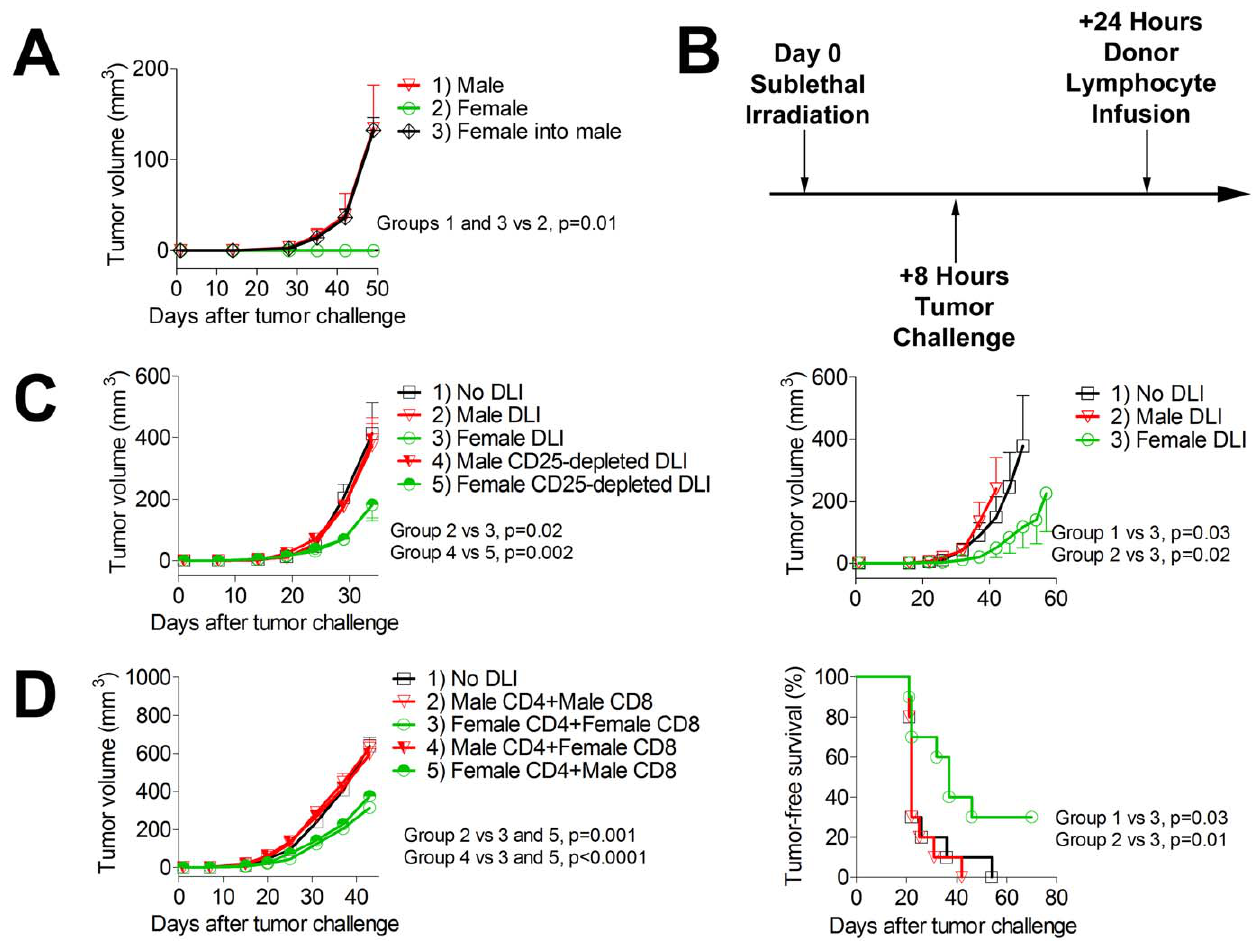
Figure 2. Adoptive transfer of female lymphocytes into male mice challenged with TRAMP-C2 controls tumor growth. A) Adult male mice were myeloablated via irradiation and transplanted with female T-cell depleted bone marrow followed by challenge with TRAMP-C2 tumors 10 weeks after transplantation. n=5 mice/group, results of a single experiment. B) Adult male mice were sublethally irradiated with 6 Gy and challenged intradermally with 1 6 10 6 TRAMP-C2. The following day, mice received a donor lymphocyte infusion (DLI) of 3 6 10 7 splenocytes i.v . n=10 mice/group, one of 3 experiments with similar results. C) Adoptively-transferred CD25 + regulatory T cells do not mediate increased tumor growth seen following male DLI. Mice were irradiated and tumor-challenged as in B, and received splenocytes that were CD25-depleted using magnetic beads where indicated. n=10 mice/group, results of a single experiment. D) Female CD4 T cells mediate delayed growth of TRAMP-C2 tumors. Mice were irradiated and tumor-challenged as in B, and then received 1.5 6 10 7 splenocytes that were in vivo CD4-depleted, mixed with 1.5 6 10 7 splenocytes that were CD8-depleted, of either male or female origin. n=10 mice/group, one of 2 experiments with similar results. doi:10.1371/journal.pone.0035222.g002 peptide epitopes derived from these antigens. Following re- stimulation with peptide-pulsed dendritic cells, we evaluated T- cell production of IFN- c . We found that vaccination of female mice with TRAMP-GM-CSF results in strong CD4 T cell responses against DBY, while male mice do not develop measurable responses against DBY, though female and male CD4 T cells had similar responses to stimulation with anti- CD3 e /anti-CD28 beads, or with phorbol myristate acetate (PMA) and ionomycin (Figure 3A). Likely this is due to the lack of central tolerance against DBY in female versus male mice and the high expression of DBY by TRAMP-C2 cells. We found that male mice do mount CD8 T cell responses against the mutated antigen SPAS-1 following TRAMP-C2 cell vaccination. Female CD8 T cells, however, exhibit stronger responses to SPAS-1 than males (Figure 3A), an unexpected finding given that expression of SPAS-1 is neither gender-restricted nor hormone-regulated. The responses to SPAS-1 was dominant over responses to other